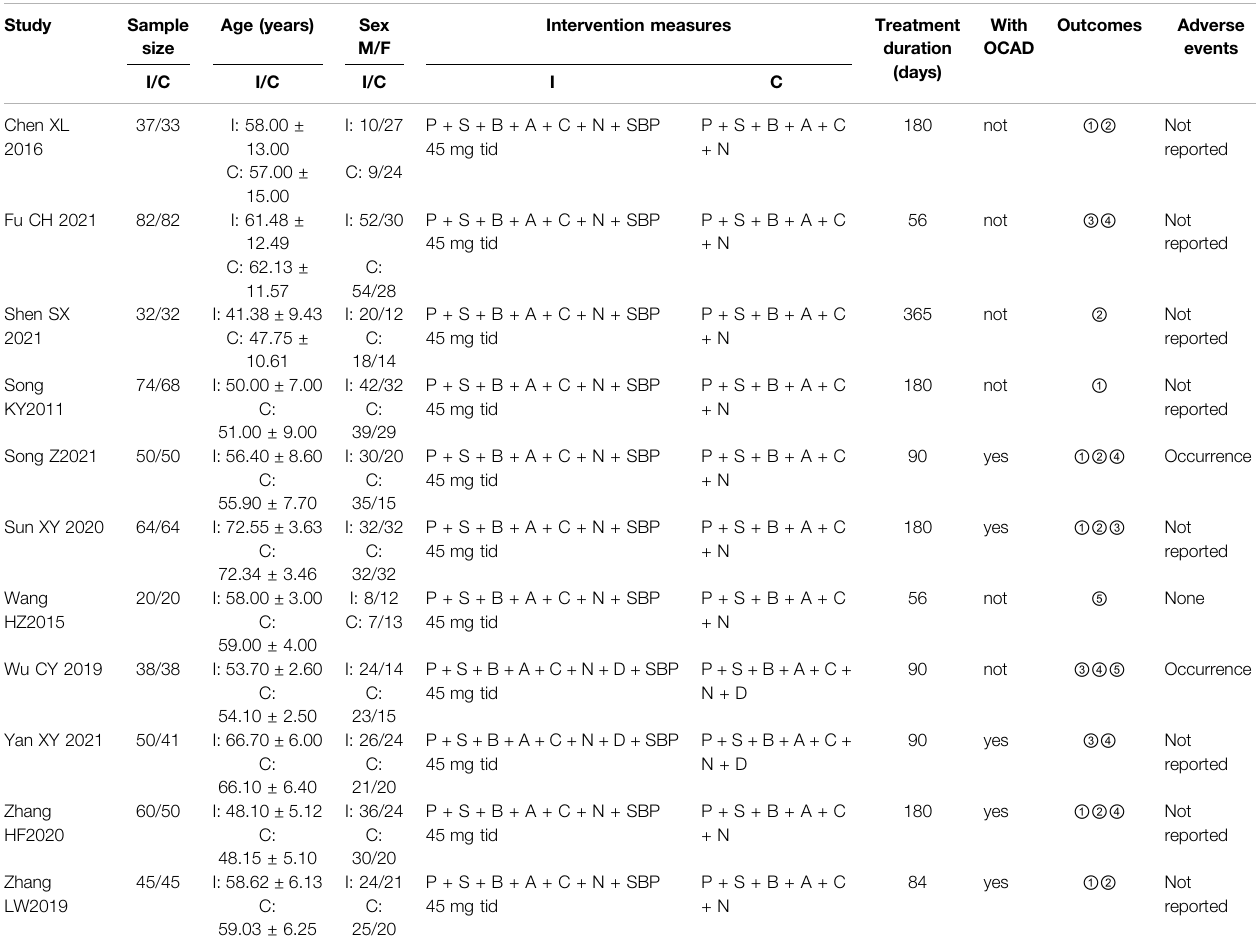
TABLE 1 | Basic characteristics of included